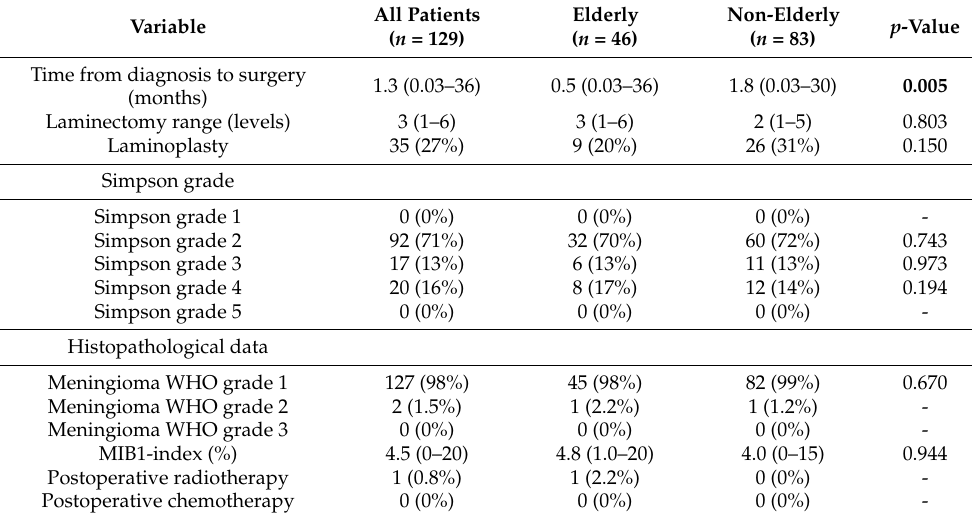
Table 3. Treatment